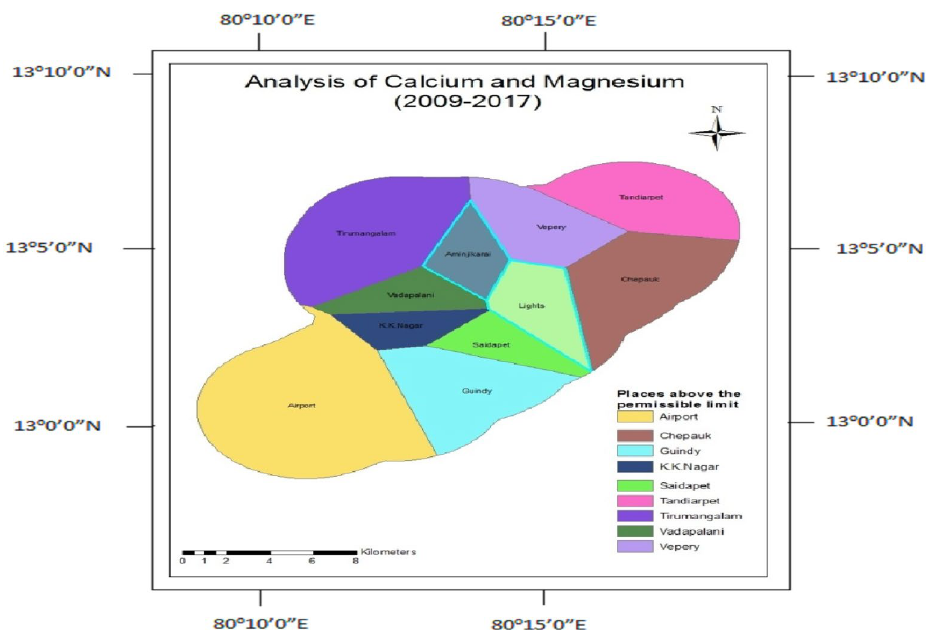
Figure 14. Analysis of calcium and magnesium for